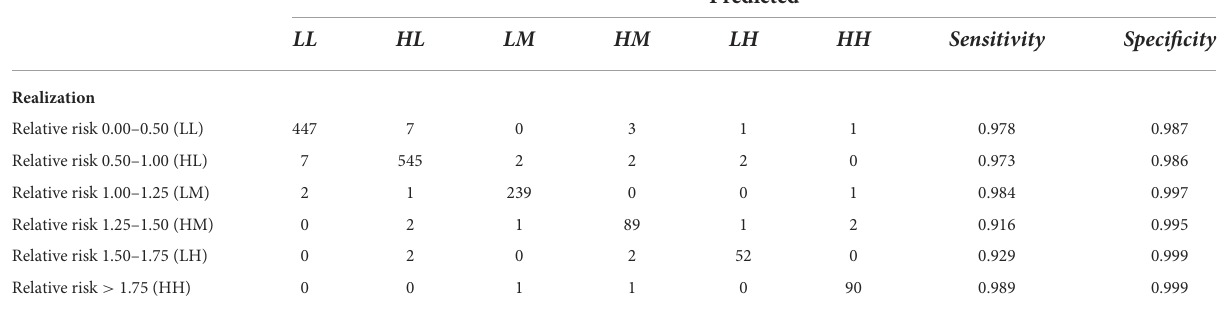
TABLE 8 Confusion matrix for December 2020 prediction of relative risk of COVID-19